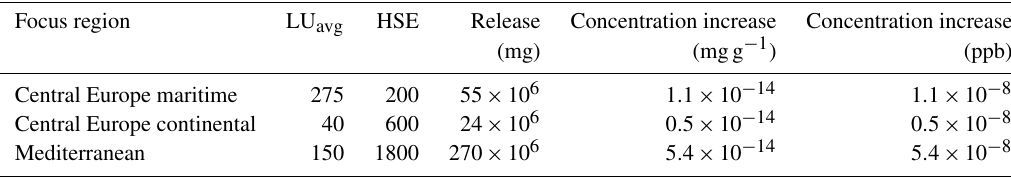
Table 7. The change in methane release (corresponding to annual emissions) is estimated as the product of the average livestock unit (LU avg ) in the barn and the estimated number of additional heat stress events (HSE). A 1gLU − 1 h − 1 higher methane emission during heat stress conditions is assumed (Hempel et al., 2016b). The average livestock unit of the reference barns was estimated as the number of animals in the barn times 500kg divided by the average body weight. Considering a total mass of the Earth’s atmosphere of approximately 5 × 10 21 g, this methane release was converted into a concentration increase, neglecting other processes that affect the methane concentration (Trenberth and Smith,